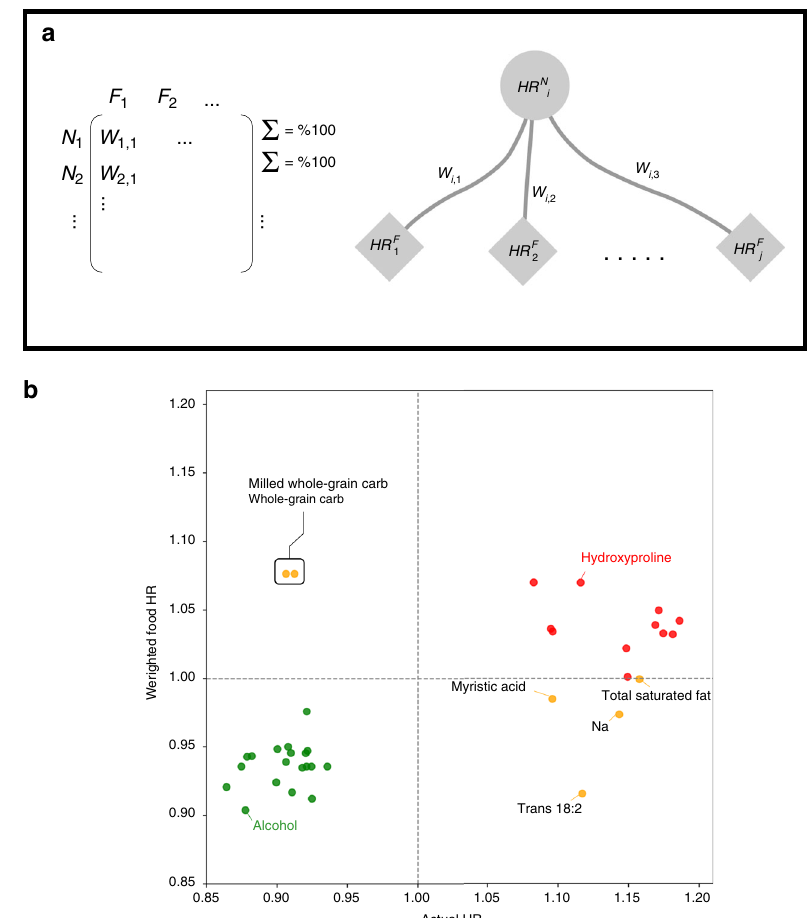
Fig. 4 Comparison between Actual Nutirent HR and Weighted Food HR. a The structure of the food composition table is shown on the left. A network is built based on a subset of the composition table where signi fi cant nutrients and signi fi cant food items are extracted. In the network on the right, the weight of a link between a nutrient and a food is proportional to the amount of a nutrient in each speci fi c food item compared with all other food items. b Points in the top right corner and in the bottom left corner correspond to the nutrients whose actual HR is in the same direction as their weighted food HR. For whole-grain carbohydrates, milled whole-grain carbohydrates, total saturated fat, trans-fatty acid 18:2, sodium, and myristic acid, the actual HR has an opposite direction compared with the weighted food HR. Source data are provided in Source Data Figure 3-b and